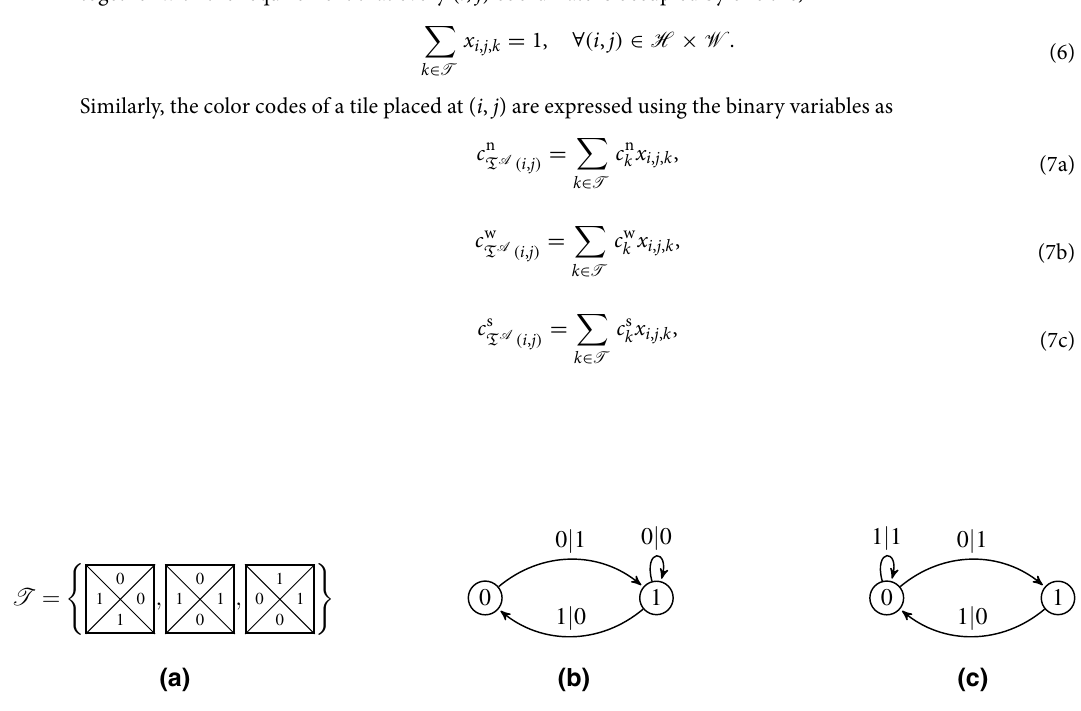
Figure 4. ( b ) Transducer and ( c ) dual transducer graphs of the tile set ( a